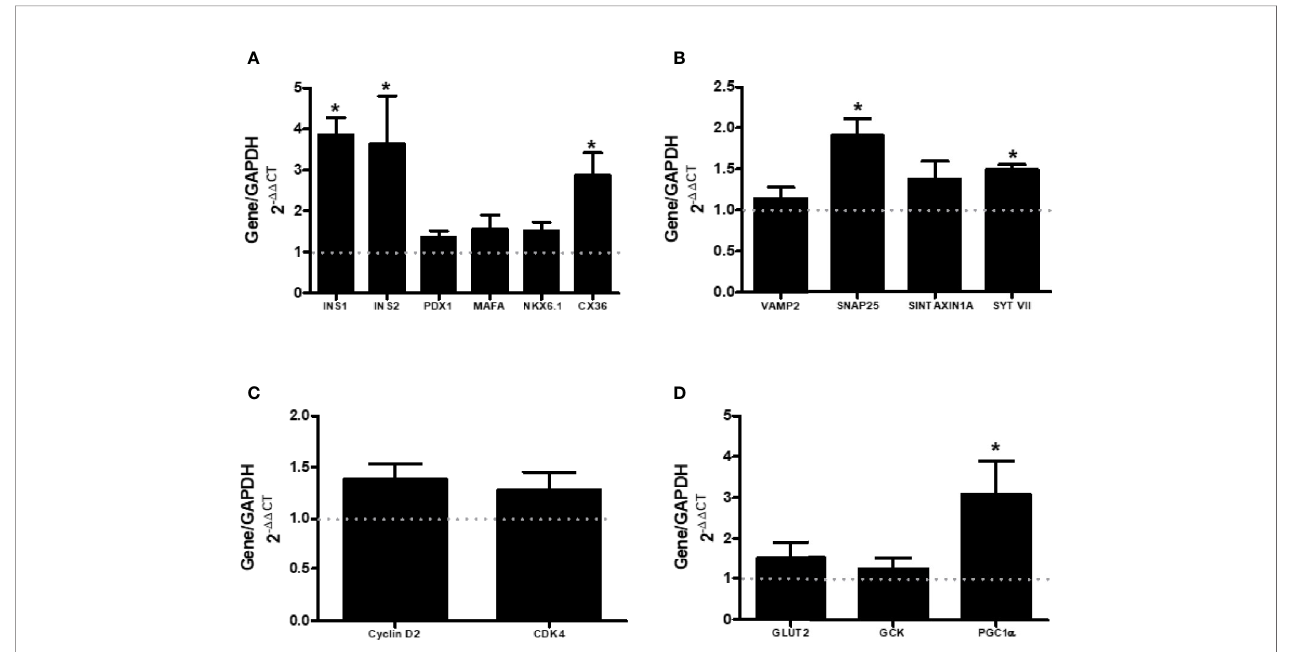
FIGURE 5 | ARHGAP21 knockdown effects on mRNA level of genes that modulate maturation (INS1, INS2, PDX1, MAFA, NKX6.1, and CX36), granule extrusion (VAMP2, SNAP25, SINTAXINA1A, and SYTVII), proliferation (CYCLIN D2 and CDK4), and metabolism (GLUT2, GCK and PGC1 a ) in pancreatic islets. Adult